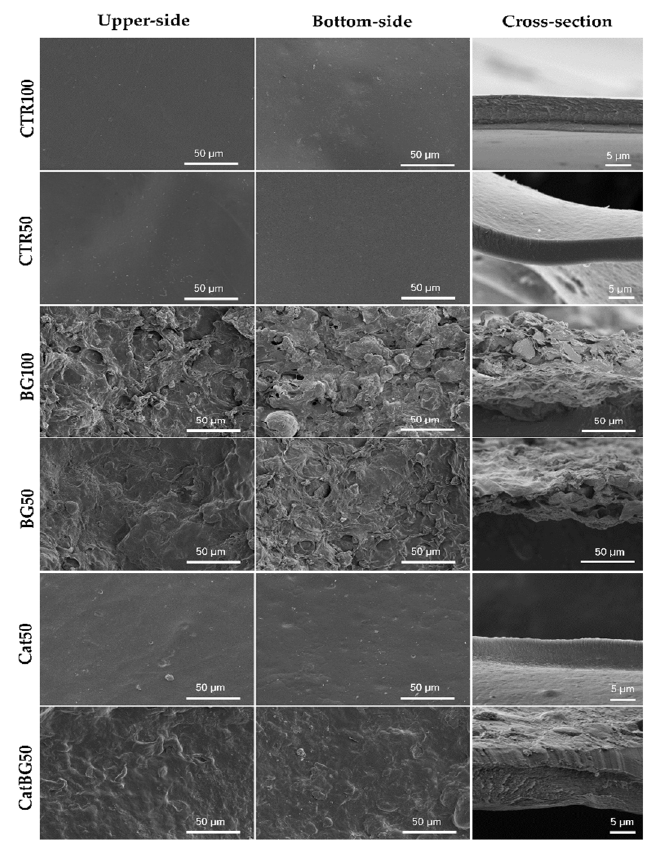
Figure 5. SEM micrographs of cross-linked LbL freestanding films.